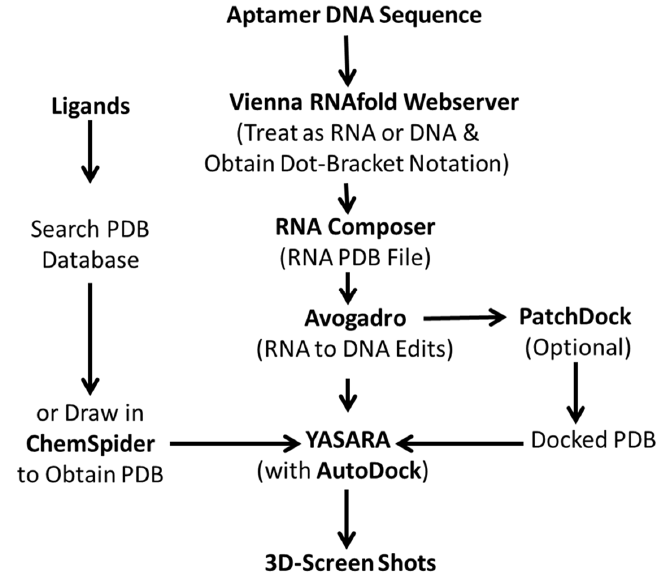
Figure 1. A generalized algorithm used by Bruno and others [16–20] for piecing together free internet software to generate static 3D aptamer structures and docking models of aptamers bound to their cognate ligands.